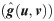
Perspective plot of space-time pair correlation function (g^(u,v)) for PRRS incident cases from July 2012 to June 2014 in the RCP-N212.Time (in weeks, from 0-wk to 104-wks) is represented by axis v; while space (in km, from 0-km to 6-km) is represented by axis u. Vertical axis represents the space and time correlation.